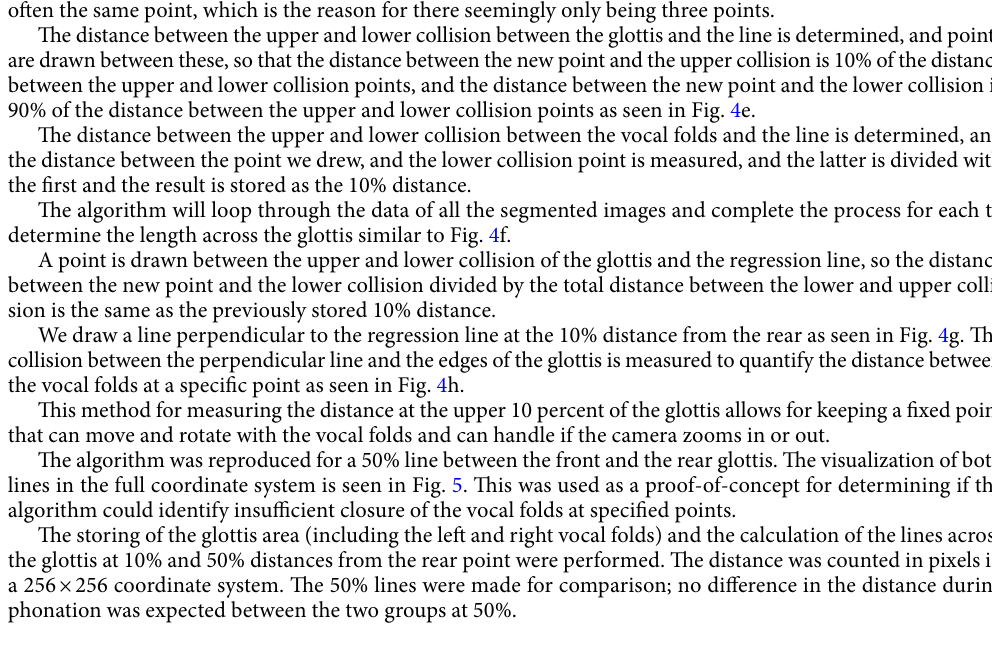
Figure 5. A single image visualizing the post-network calculations of the 10% and 50% lines from the rear of the glottis. The right and left vocal folds are marked in yellow and blue, respectively, and the glottis is marked in